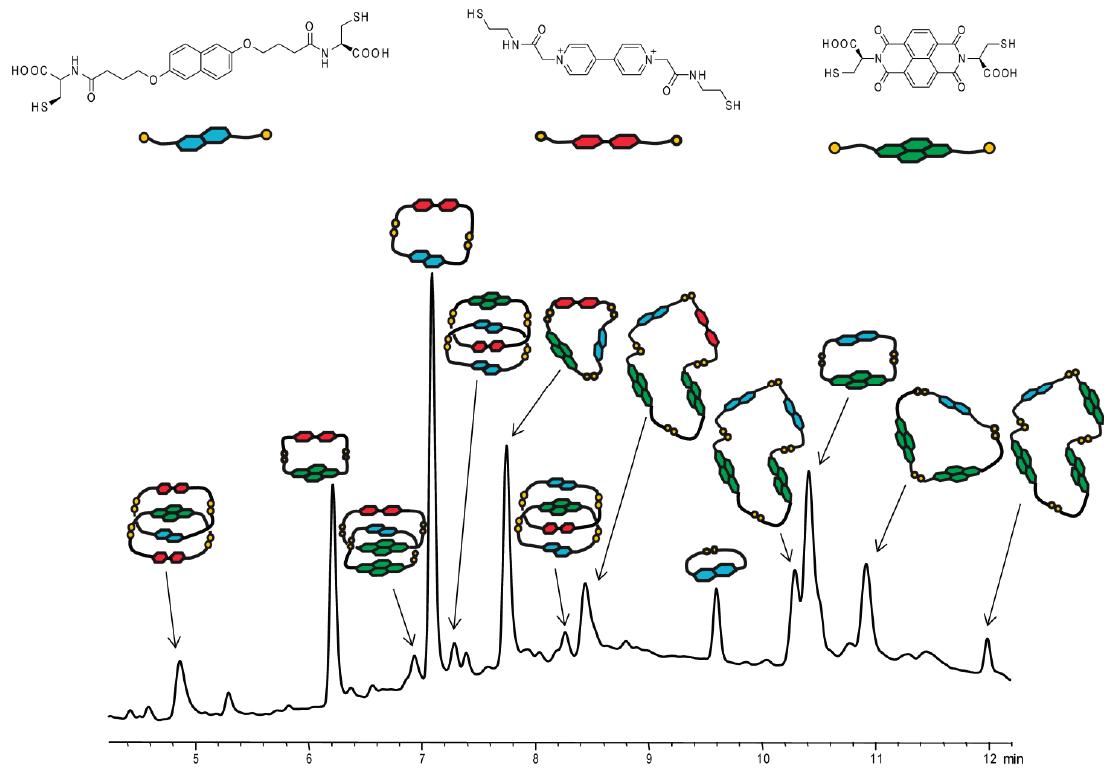
Figure 3. High-Performance Liquid Chromatography (HPLC) analysis of an aqueous library composed of 1 , 6 and 7 (1:1:1 molar ratio, 5 mM